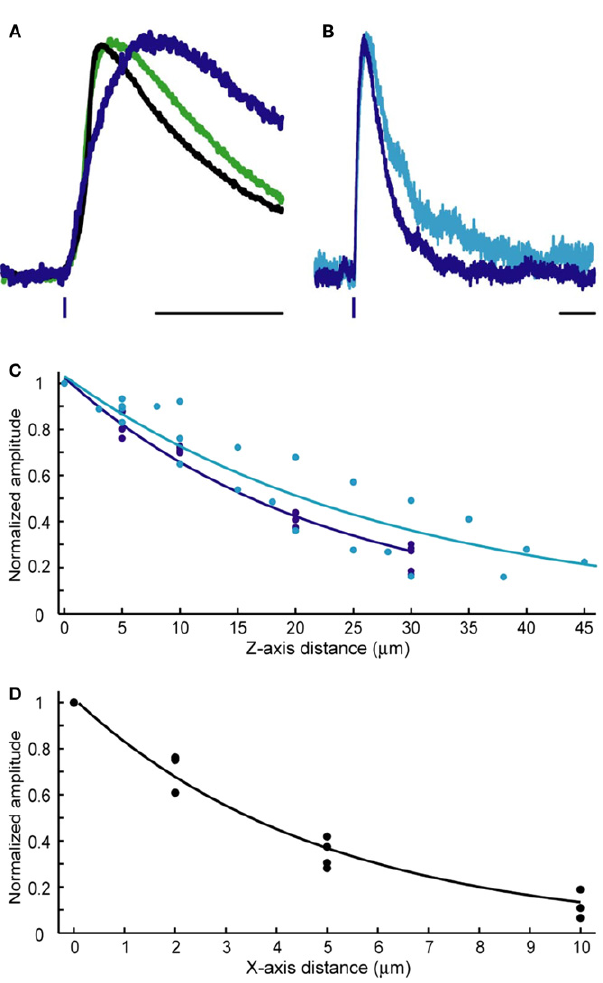
Figure 3 | Kinetics and spatial resolution of RuBi-GABA uncaging. (A) Scaled GABAergic responses. Average somatic mIPSC evoked by sucrose application (black), average mIPSC (green), and average uncaging response elicited by a 0.5 ms 473 nm laser pulse (blue). Scale bar: 20 ms. (B) Slight